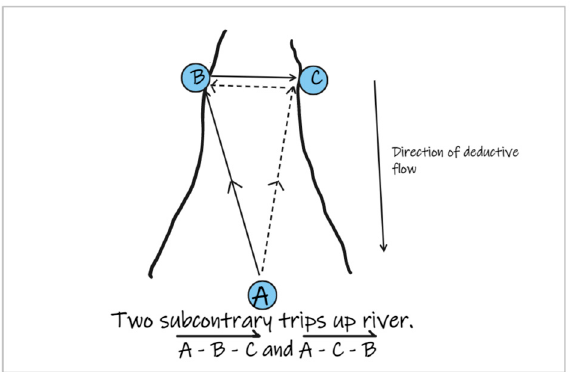
Figure 5. Peirce’s subcontrary ways of rowing up the deductive stream. The path from A to B to C is subcontrary to that from A to C to B.